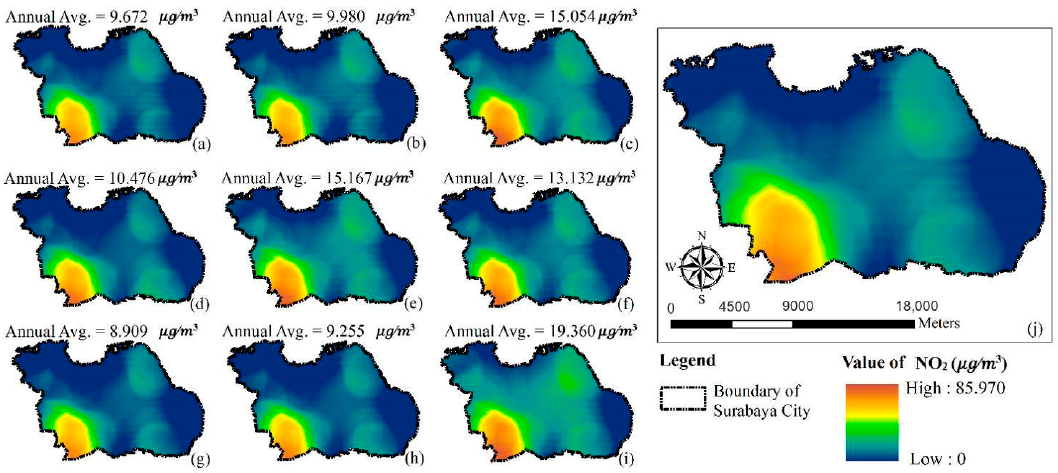
Figure 7. Prediction maps of NO 2 concentration variations using GTWR model: ( a ) 2010 ( b ) 2011 ( c ) 2012 ( d ) 2013 ( e ) 2014 ( f ) 2015 ( g ) 2016 ( h ) 2017 ( i ) 2018 ( j ) average from 2010 to 2018.